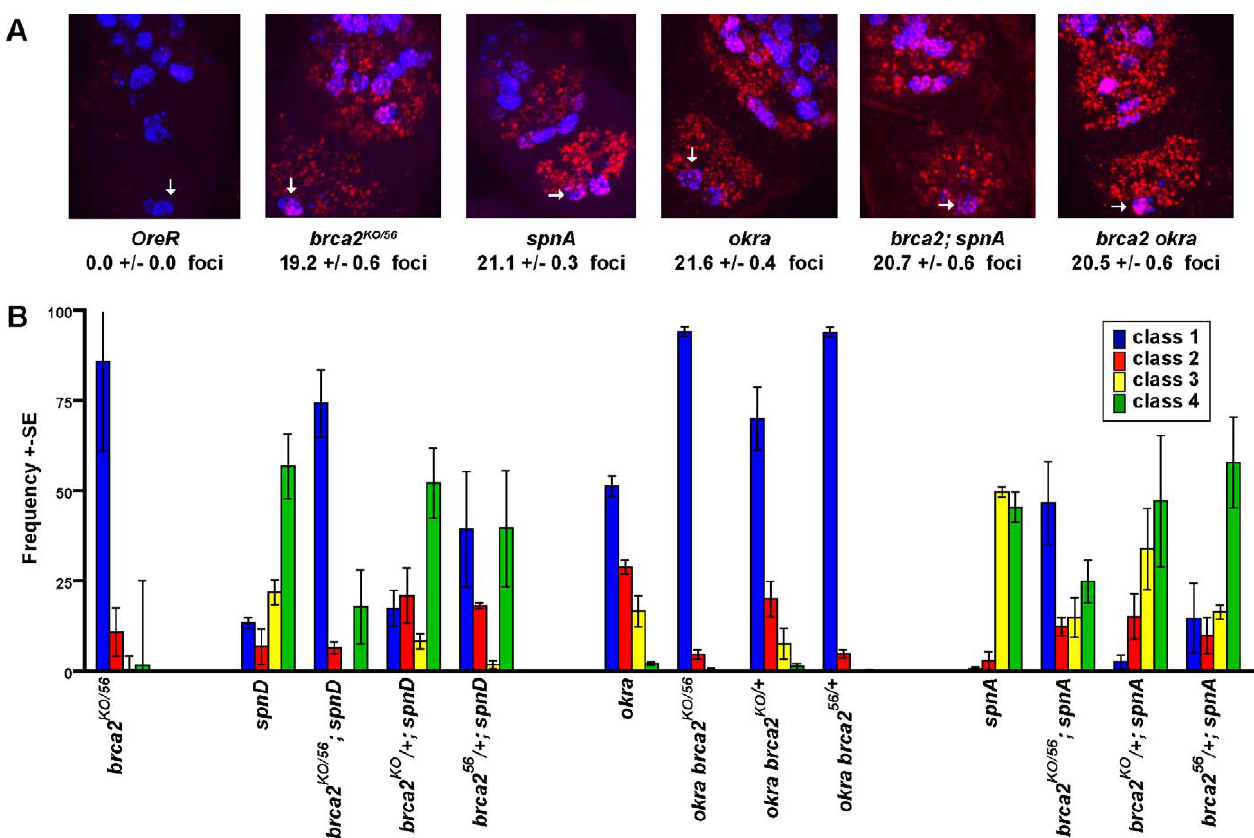
Figure 3. brca2 Mutants Suppress the Patterning Defects of DNA Repair Mutants That Activate the Meiotic Recombination Checkpoint (A) c -H2AV(red) foci in the germarium, with the oocyte in region 3 marked by the arrow. Pro-oocytes are marked by C(3)G staining (blue). Images represent a projection of stacks taken through whole germaria. Number of c -H2AV foci in region 3 is the average number of foci þ / (cid:2) standard error from a total of 14, 14, 11, 7, 10, and 10 region 3 oocytes counted for OreR, brca2, spnA, okra, brca2; spnA, and brca2 okra , respectively. (B) Frequency of the different classes of eggshells laid by females fed yeast for 5–7 days. Classes are as described in Figure 2. Note the increase in the wild-type like eggshells (blue) in the double mutants. Error bars represent the standard error between 3 independent experiments. Total number of eggs counted per genotype were: 1149, 73, 1687, 456, 645, 1663, 922, 1199, 341, 339, 455, 268, and 196,